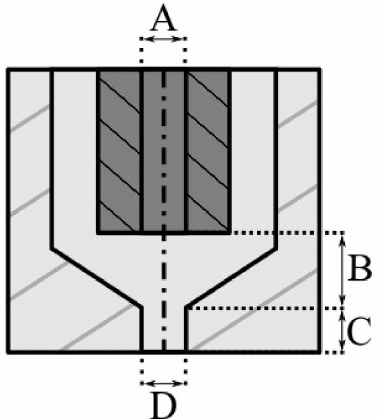
Figure 1. Scheme of used air-core–liquid-ring (ACLR) atomizer geometry. ( A ) diameter of the gas capillary (1.5 mm); ( B ) length of the mixing zone (2.4 mm); ( C ) length of the exit orifice (1.5 mm); ( D ) diameter of the exit orifice (1.5